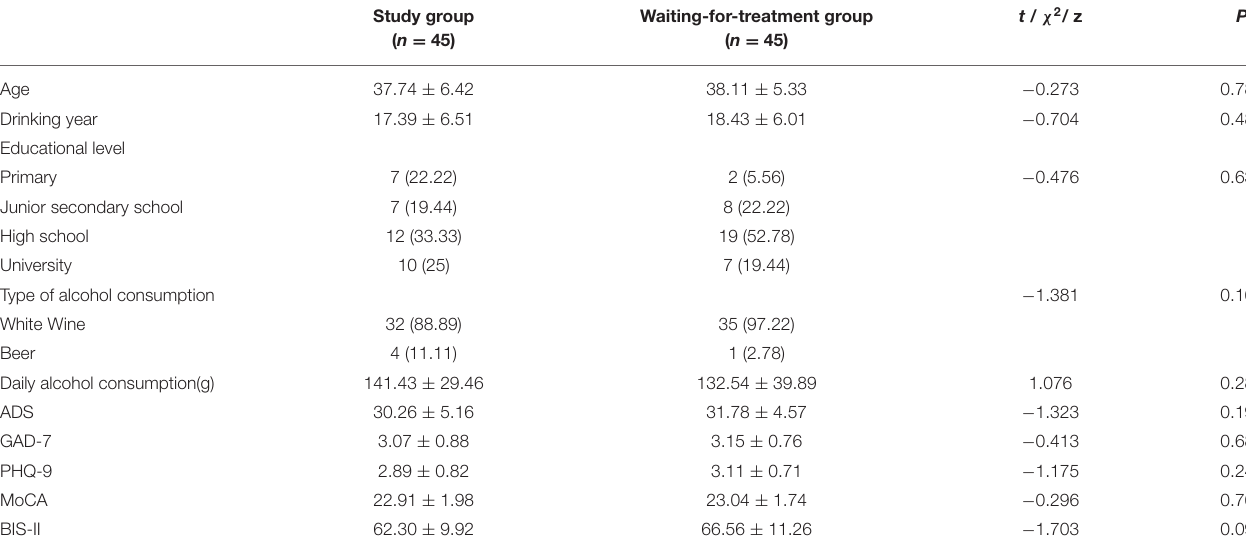
TABLE 1 | Comparison of basic demographic information between the study group and the waiting-for- treatment group [x ± s/ n